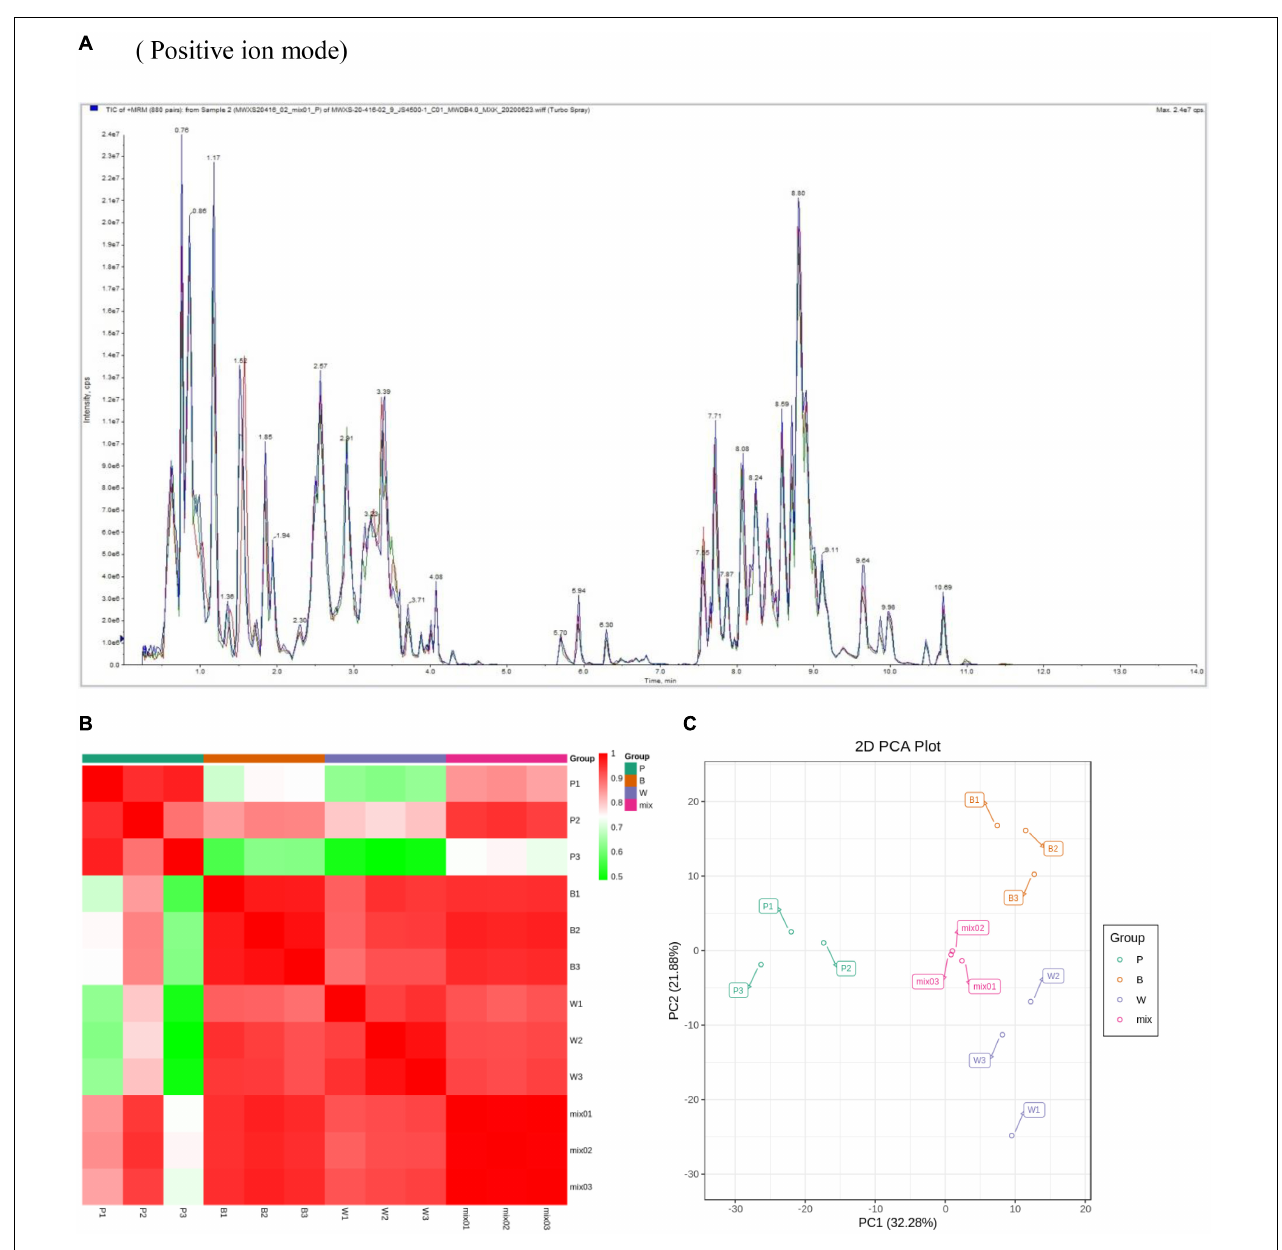
FIGURE 3 | Overall qualitative and quantitative analyses of metabolomics data. (A) TIC overlap map of QC samples by MS detection. Abscissa represents retention time (min) of metabolite detection. Ordinate represents intensity of ion current (cps: count per second). (B) Pearson’s correlation coefficients among P (purple), B (blue), W (white), and QC samples (mixture). (C) PCA of P, B, W, and QC samples (mixture). X -axis represents the first principal component. Y -axis represents the second principal component.